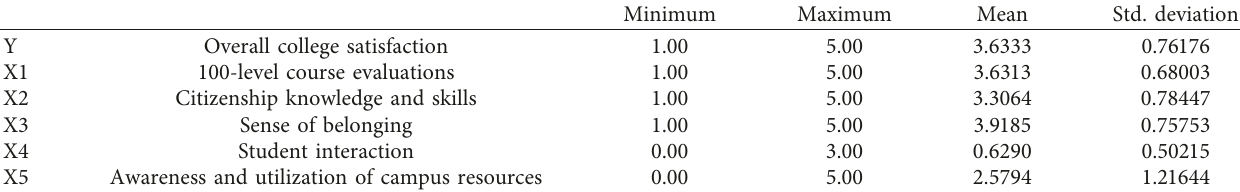
Table 3: General descriptive statistics—minimum, maximum, mean, and standard deviation.